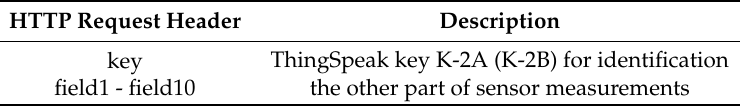
Table 3. Data format description for M-3A and